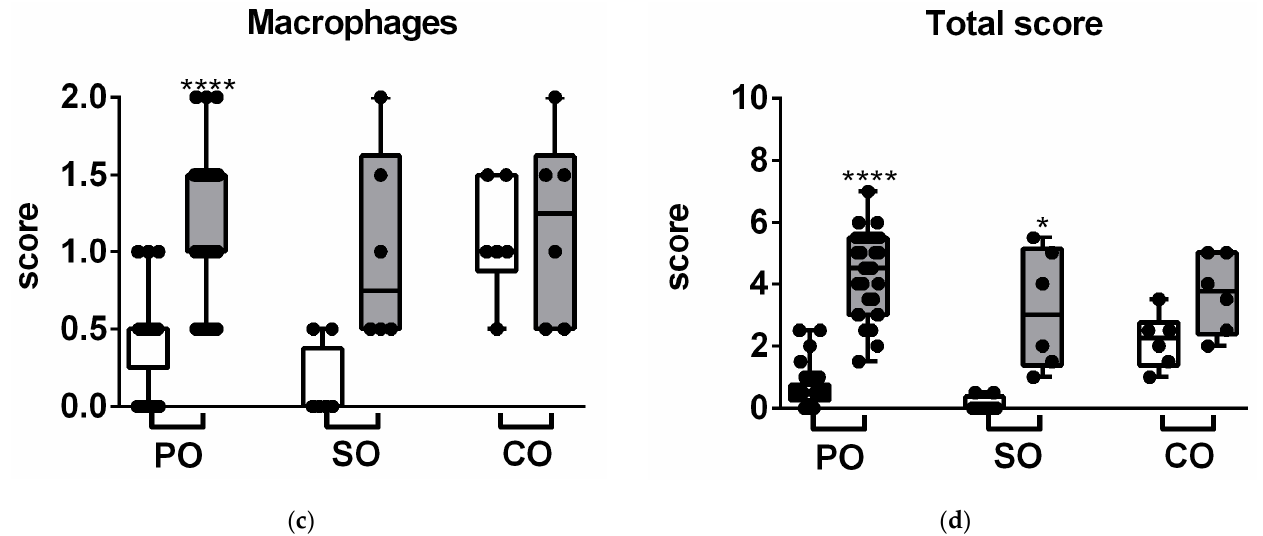
Figure 3. Semiquantitative evaluation of ( a ) perivascular and peribronchial edema, ( b ) accumulation of neutrophil granulocytes, ( c ) macrophages and ( d ) total score of lung histopathological alterations. Individual data points ( n = 6–8 mice/treatment groups and 29 in the control groups) are demonstrated with the medians and the SEM (* p < 0.05, **** p < 0.0001 vs. respective PBS-treated mice; Kruskal–Wallis analysis followed by Dunn’s post-test).